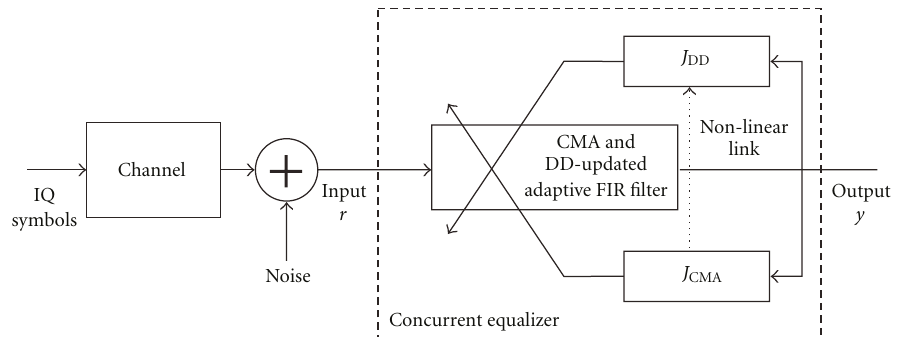
Figure 1: CEQ equivalent baseband model.